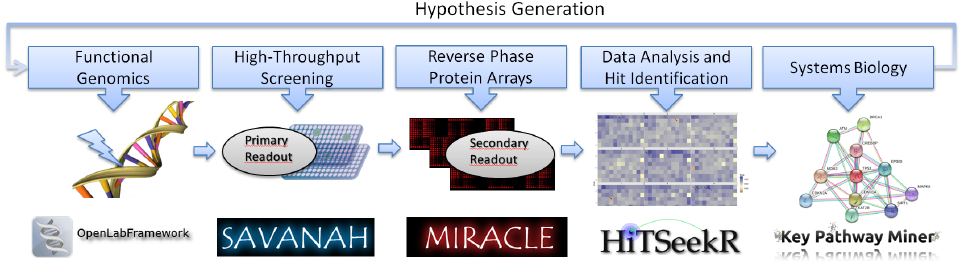
Figure 1: The web tools integrated here via Docker compose constitute a drug target screening platform. (i) Open- LabFramework is used to track functional genomics experiments that yield modified cell lines. (ii) These cell lines are then typically seeded across dozens of microtiter plates in a high-throughput screening experiment logistically tracked by SAVANAH. Here, each well constitutes its own experiment, e.g. a single gene knockout. The outcome is often a fluo- rescence based value of metabolic activity. (iii) Cells left-over from high-throughput screens can be lysed and deposited on reverse-phase protein arrays. MIRACLE tracks samples throughout this process and allows for the analysis of pro- tein readout data. (iv) Primary and secondary screening results are processed and normalized in HiTSeekR to facilitate identification of samples that exhibit a phenotype of interest. (v) Genes of interest are finally subjected to systems biology analysis, leading to the generation of new